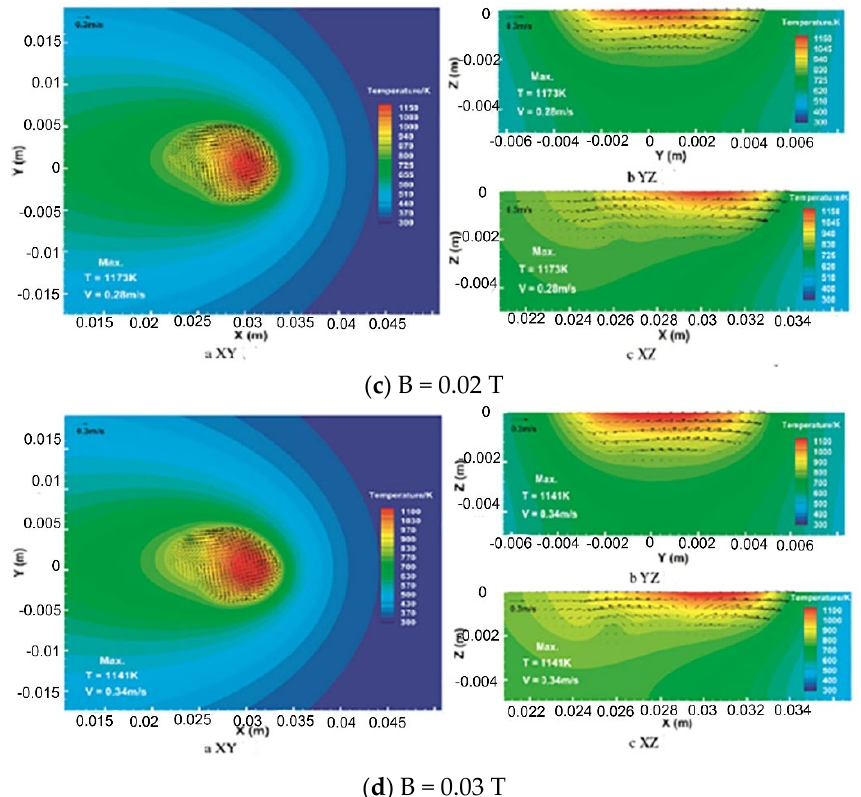
Figure 5. Temperature field and flow field of molten pool under different magnetic field strength.